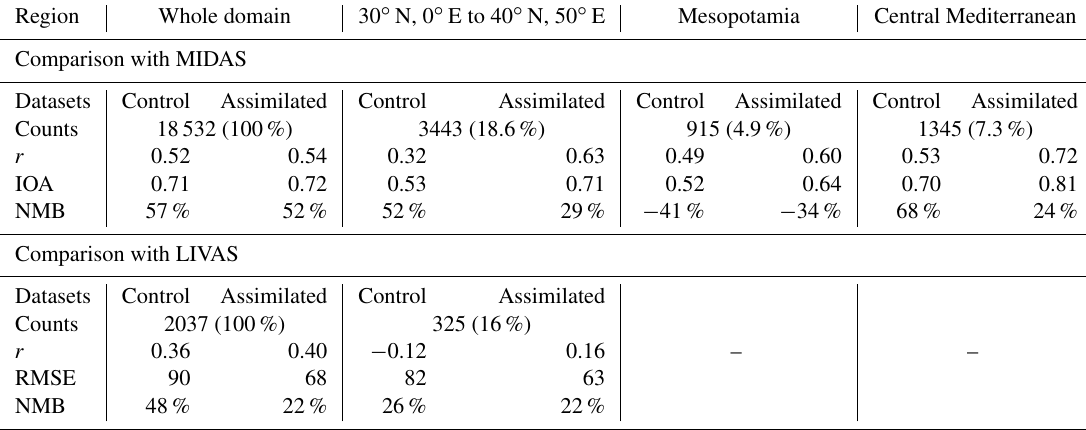
Table 3. Statistical comparison of modelled to observed products for MIDAS and LIVAS for the period 14–25 October 2020. Region Whole